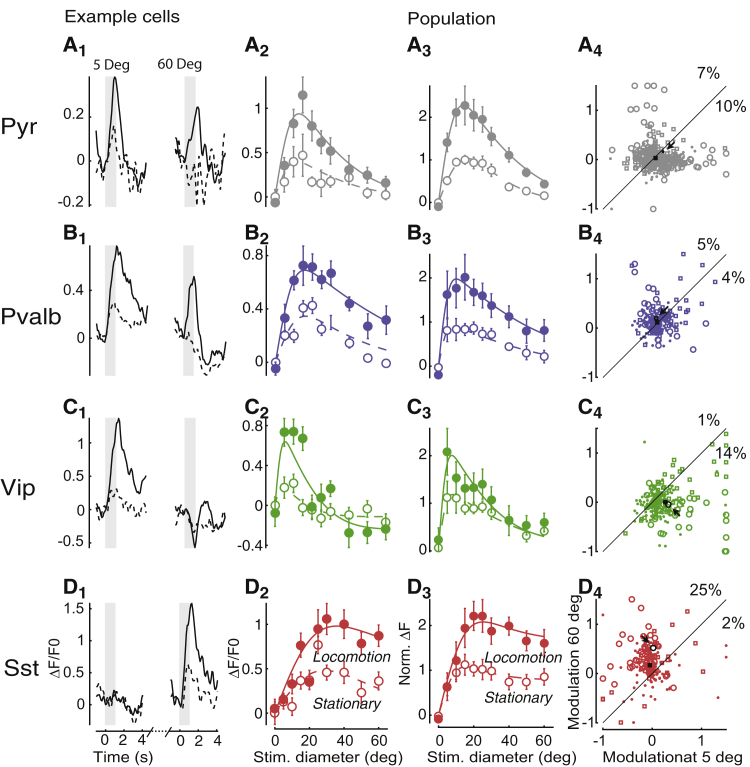
Locomotion Increases Sst Cell Responses to Large Stimuli and Vip Cell Responses to Small Stimuli(A1) Responses of a representative Pyr neuron. Black curves show trial-averaged response in the stationary (dashed line) and locomotion (continuous line) conditions. Panels show responses to stimuli of diameter 5° (left) and 60° (right). Gray shaded regions indicate the 1 s stimulus presentation period.(A2) Size-tuning curve for this example cell. Solid line, locomotion; dashed line, stationary. Error bars correspond to standard error.(A3) Size-tuning curve averaged over Pyr cells after normalization. Solid line, locomotion; dashed line, stationary. Error bars correspond to standard error.(A4) Scatterplot showing change with locomotion of normalized responses to large stimuli (diameter 60°; y axis) and to small stimuli (diameter 5°; x axis). Circles represent cells whose responses have a significant interaction between size and locomotion (multi-way ANOVA over stimuli of diameter 5° and 60° only), squares represent cells that did not have a significant interaction but did have a significant effect of locomotion, and dots represent cells with no significant effect of locomotion. Arrow marks example cell shown in (A1) and (A2); square marks mean response. Numbers above and to the right of the dashed diagonal represent the percentage of cells with a significant positive or negative interaction between stimulus size and running speed.(B–D) Similar analysis for Pvalb (B), Vip (C), and Sst (D) neurons.